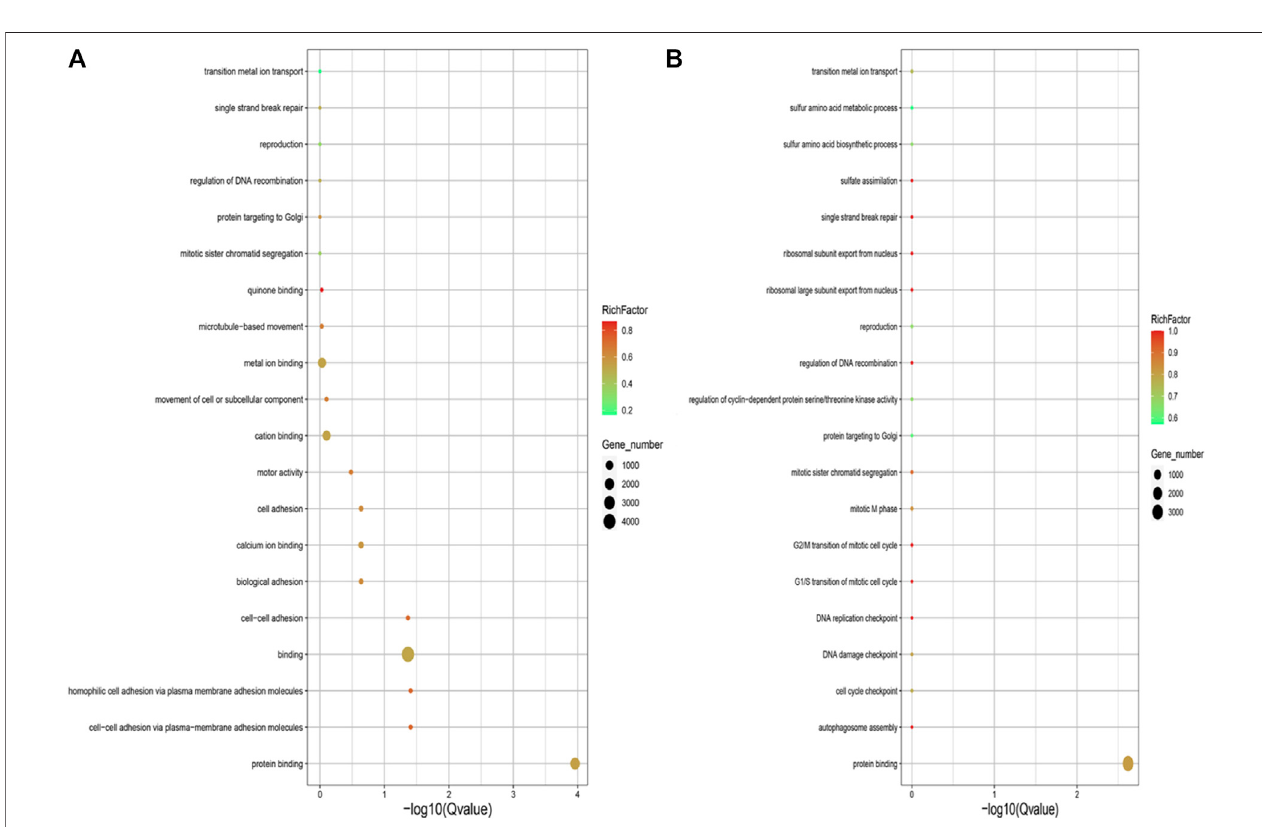
FIGURE4|(A) GOannotationanalysisofSNPslocatedinupstreamandexonregioninthecontrolgroup. (B) GOannotationanalysisofSNPslocatedinupstream and exon region in the EMS treatment group.